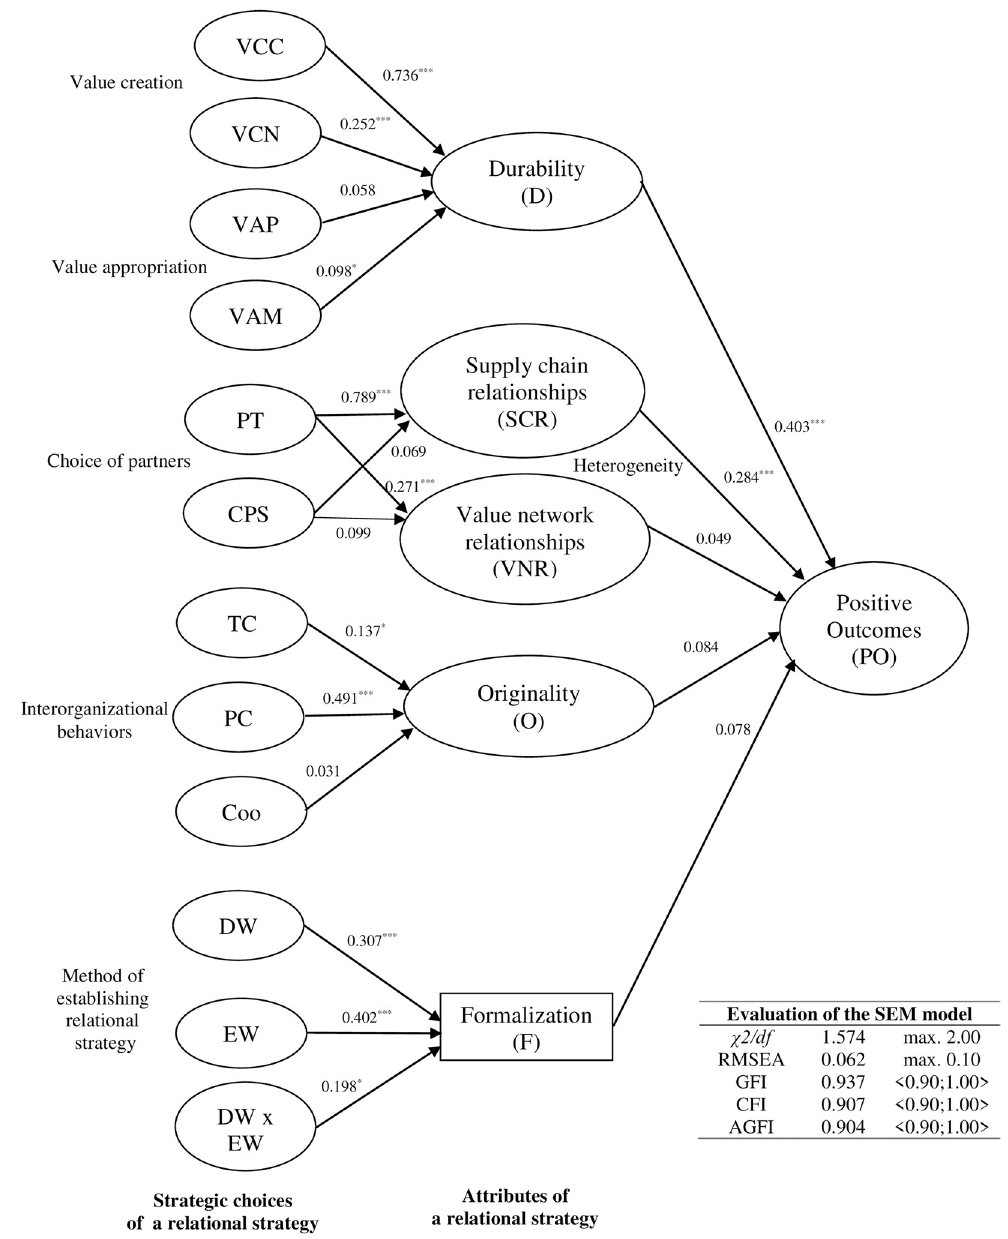
Fig 2. SEM model. Note: ��� p < 0.001; �� p < 0.01; � p < 0.05.